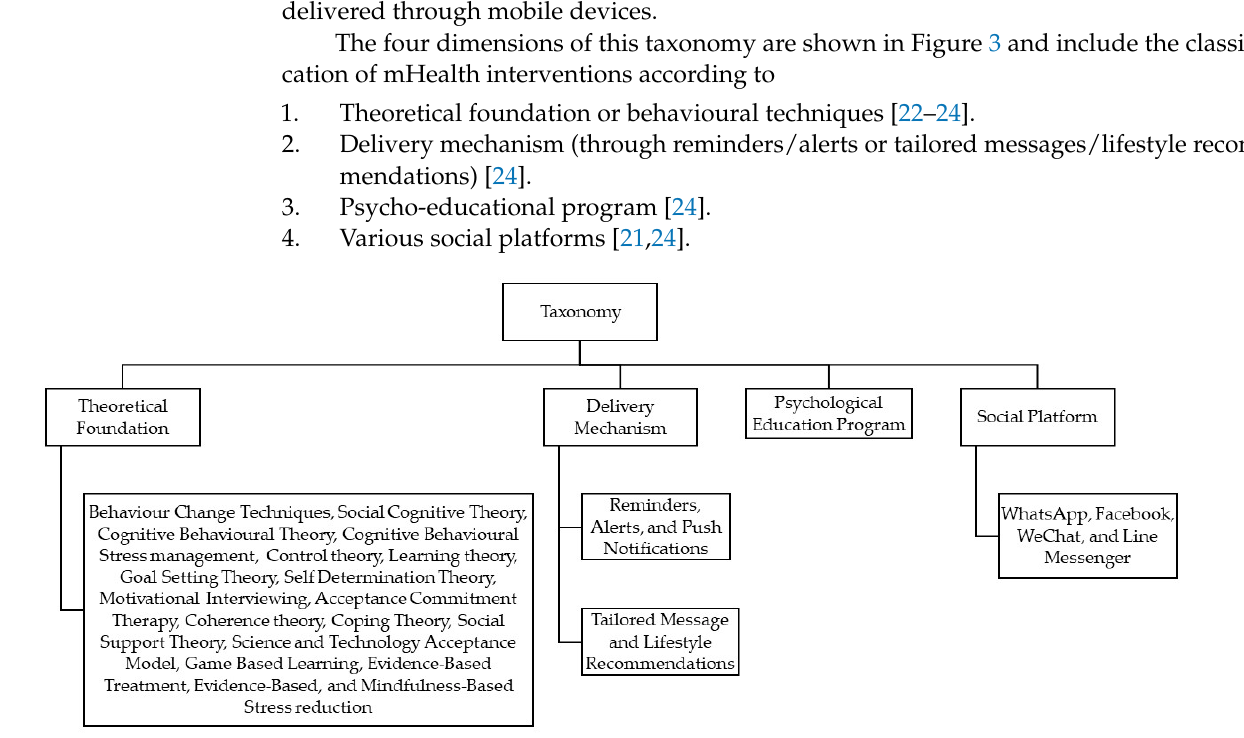
Figure 3. Flow of classification of the studies via taxonomy.